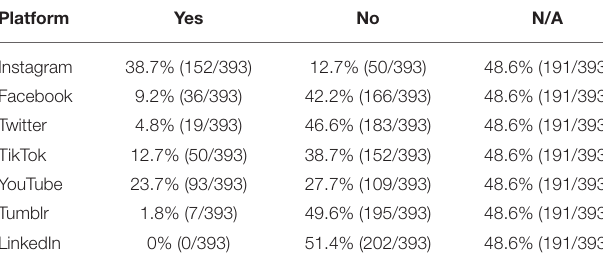
TABLE 1 | Use of social media platforms.